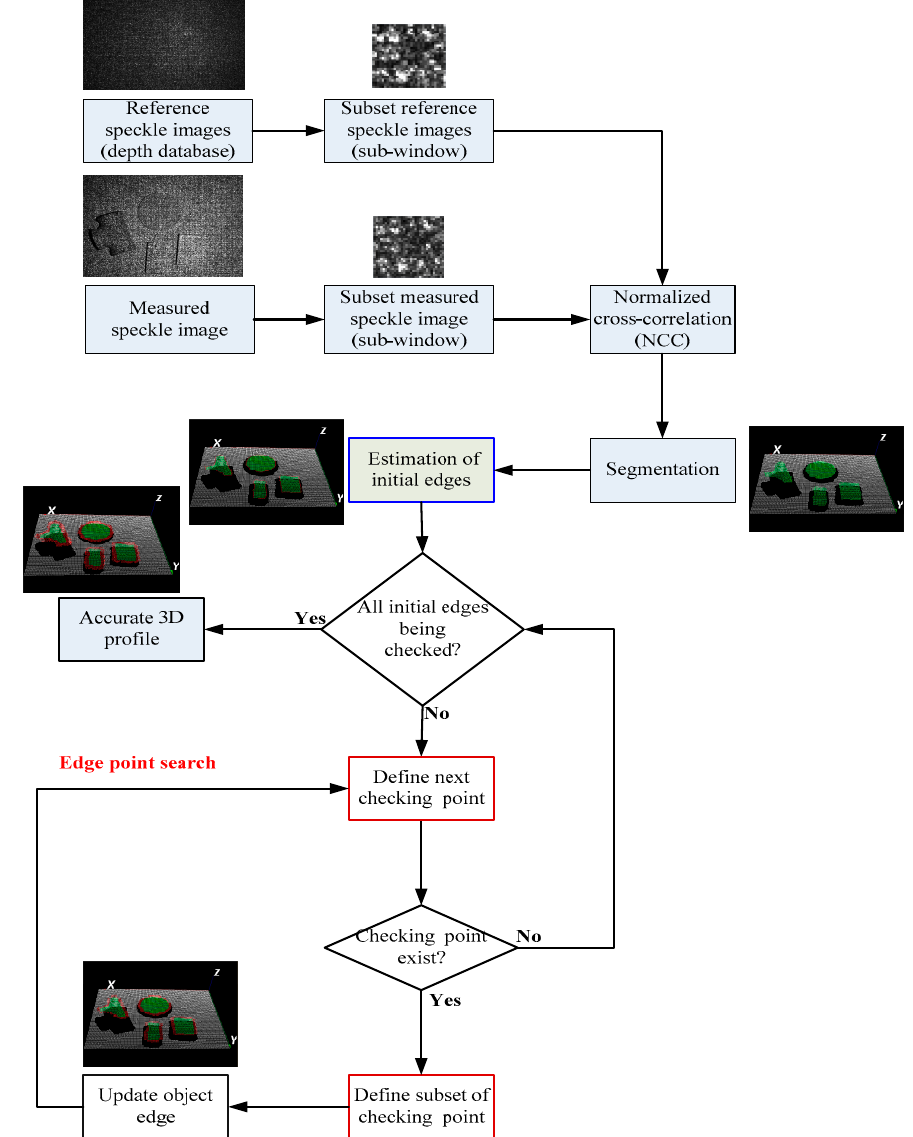
Figure 7. Flowchart of the developed approach.